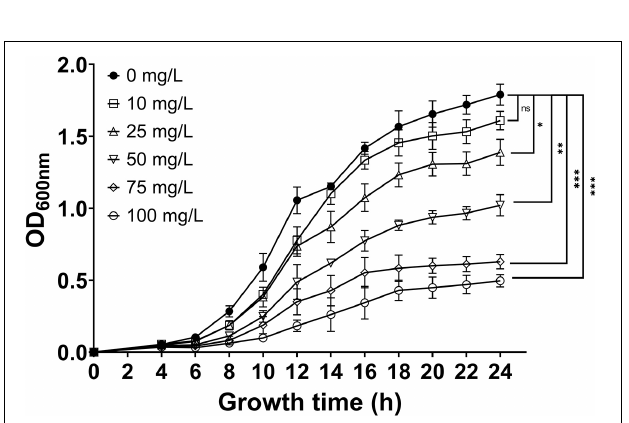
FIGURE 2 | The effect of 7-methoxycoumarin at concentrations ranging from 10 to 100 mg/L on the growth of R. solanacearum , (* indicates p < 0.05, ** indicates p < 0.01, and *** indicates p < 0.001). R. solanacearum were determined by the solid dilution method.